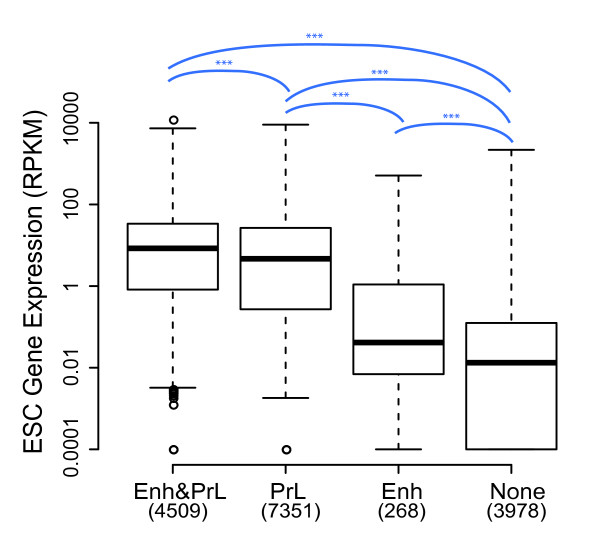
Enhancer and promoter-like candidates co-ordinately regulate gene expression. Boxplots of ES cell gene expression of the genes closest to various subsets of Enh and PrL candidates. Enh&PrL denotes genes with at least one of both Enh and PrL closest to their TSSs; PrL set denotes genes with PrL but not Enh closest to them and vice versa for Enh set; None set denotes genes without any Enh and PrL closest to them. The numbers in brackets below each set show the counts of genes within the category. The y-axis denotes gene expression represented by RPKM plotted on a log scale. Distributions of gene expression are all significantly higher compared to sets on their right (*** p-values <10−7).